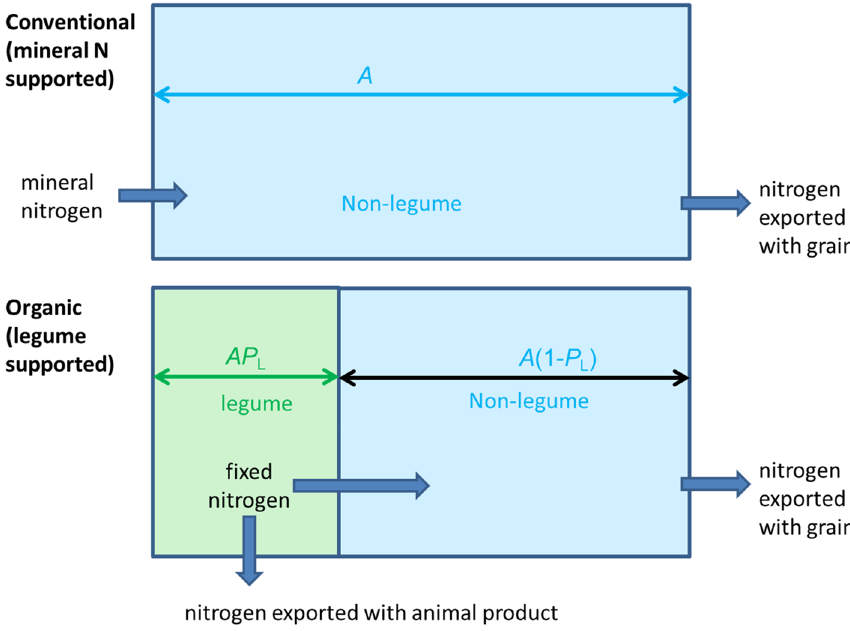
Figure 3. Simplified representation of the